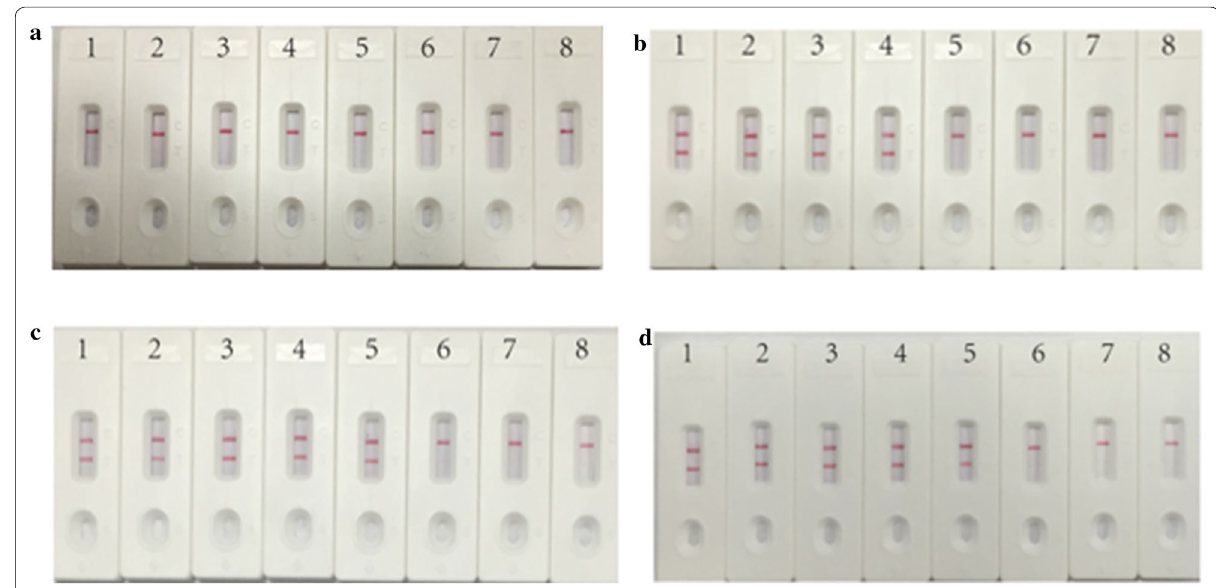
Fig. 5 Optimal detection time required for A. baumanni MCDA-LFB assay. Four different reaction times ( a 10 min; b 15 min; c 20 min; d 25 min) were evaluated at 62 °C. Biosensors 1–8 represent A. baumanni strain ATCC19606 DNA levels of 10 ng, 100 pg, 10 pg, 1 pg, 100 fg, 10 fg and 1 fg per reaction, and a blank control (DW), repectively. The best sensitivity was observed when MCDA lasted for 20 min ( c )